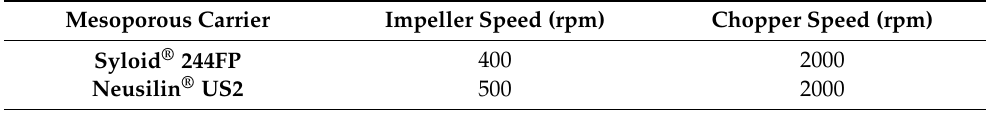
Table 1. Process parameters set on HS